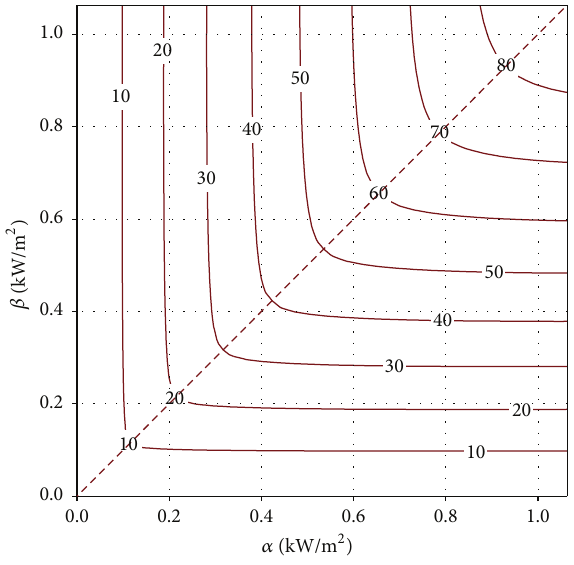
Figure 10: Isopower contours in 𝛼 - 𝛽